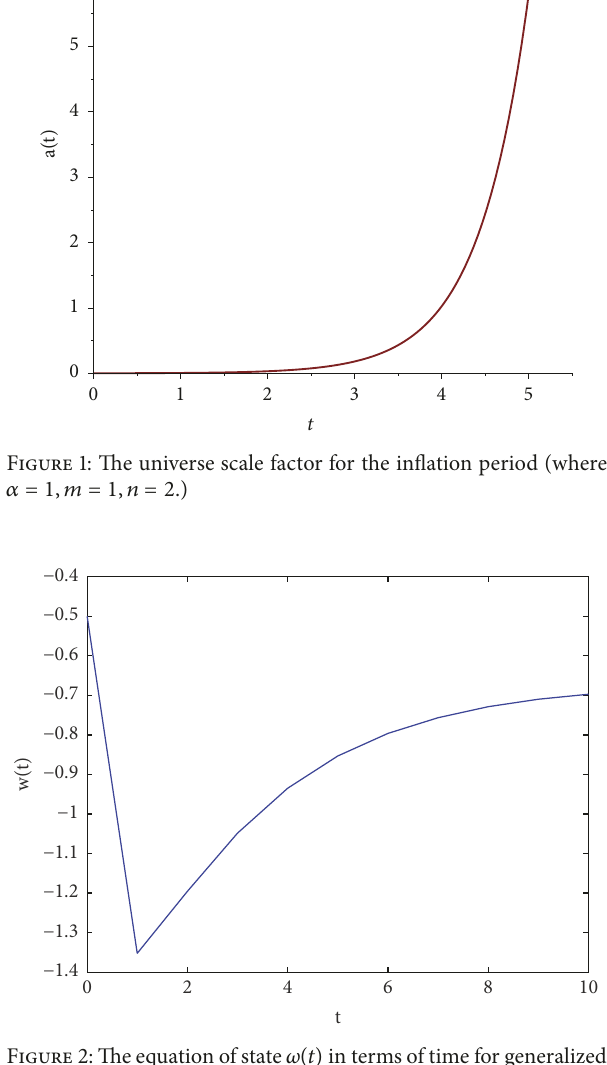
Figure 2: The equation of state 𝜔(𝑡) in terms of time for generalized RS model with 𝐹(𝑇,Θ) for 𝛼 = 1,𝑚 = 1,𝑛 = 2